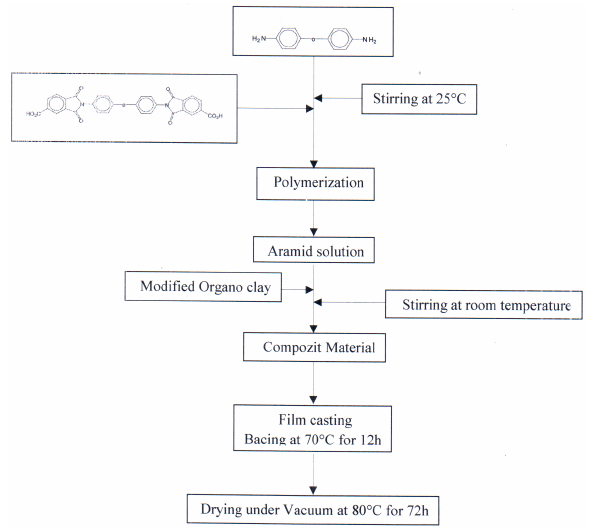
Figure 3. Flow sheet diagram for the synthesis of PAI- nanocomposites film 4a and